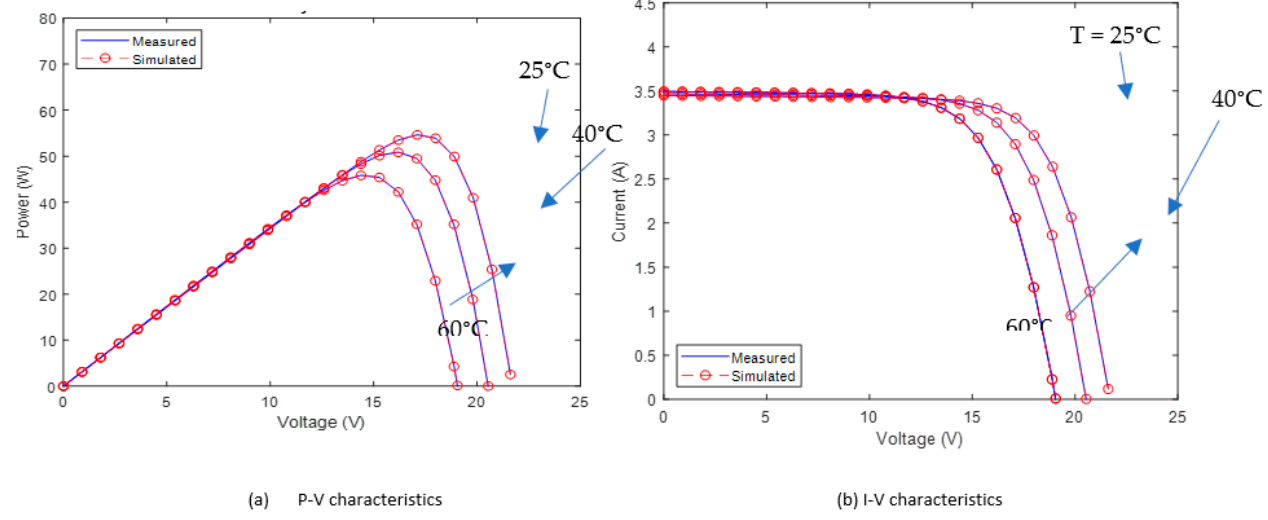
Figure 21. Depiction of the measured and simulated data obtained by MJSO on SM55 under different T. Table 16. The estimated parameters by MJSO at various G and T levels based on